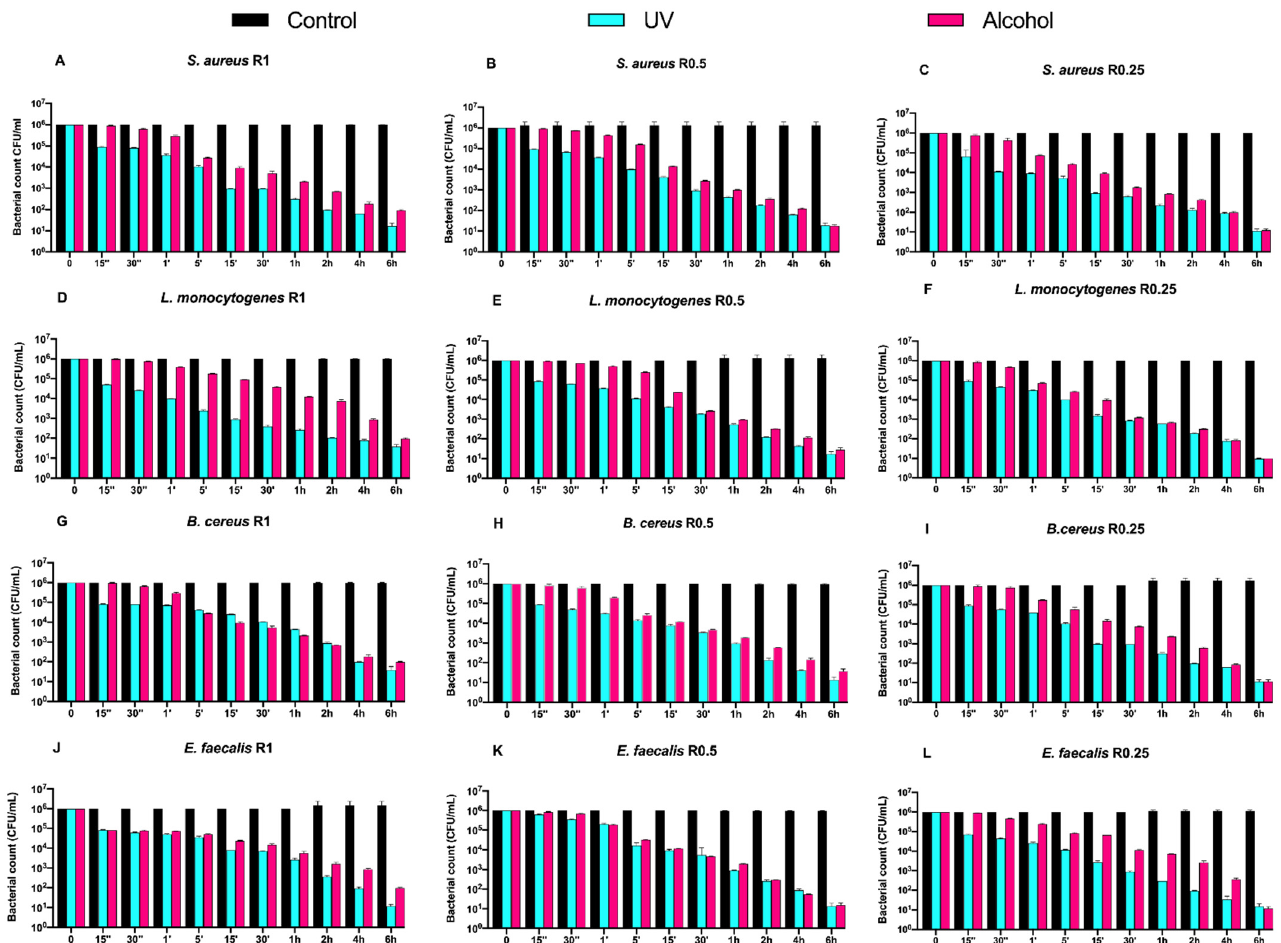
Figure 2. Graphical representation of Gram-positive bacterial counts (A-L) at different exposure times on uncoated aluminum disks with different surface roughness (R0.25, R0.5 and R1 μ m) and subjected to UV and alcohol sanitizing methods.